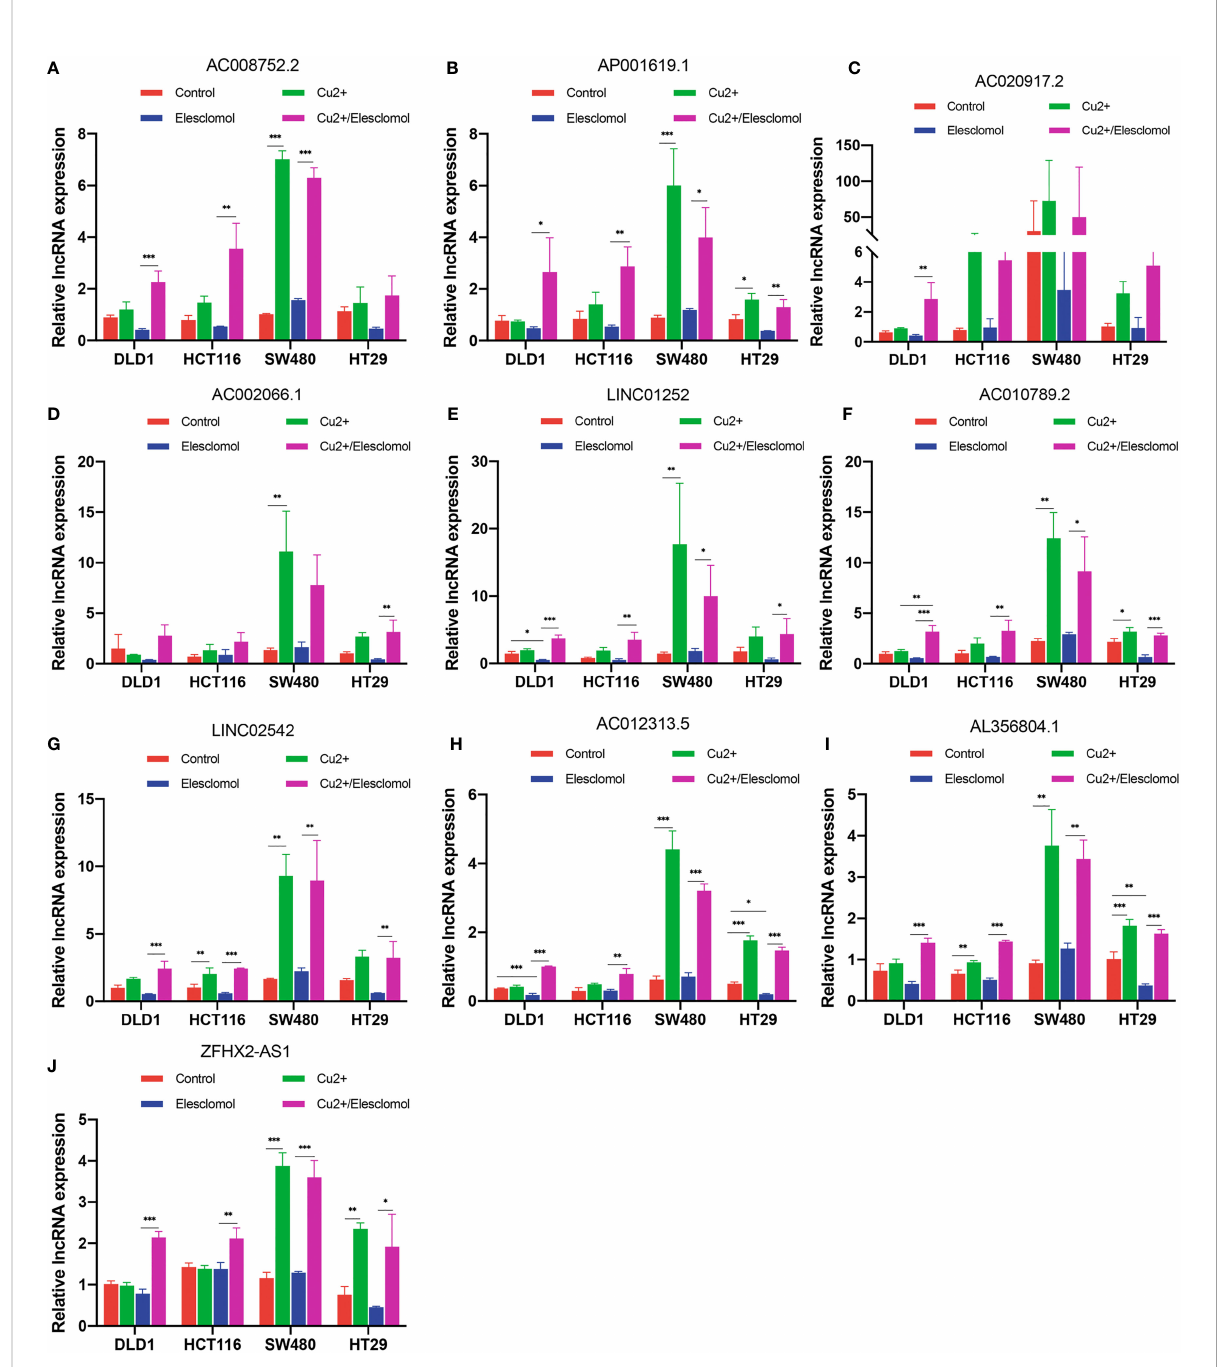
FIGURE 9 Regulation of cuproptosis in ten lncRNAs. QRT-PCR showing lncRNA expression (A – J) of cells treated with indicated drugs for 24 h (n = 3). CuCl 2 (2 m M), elesclomol (20 nM), both CuCl 2 (2 m M) and elesclomol (20 nM). nsP >= 0.05, *P < 0.05, **P < 0.01, ***P <